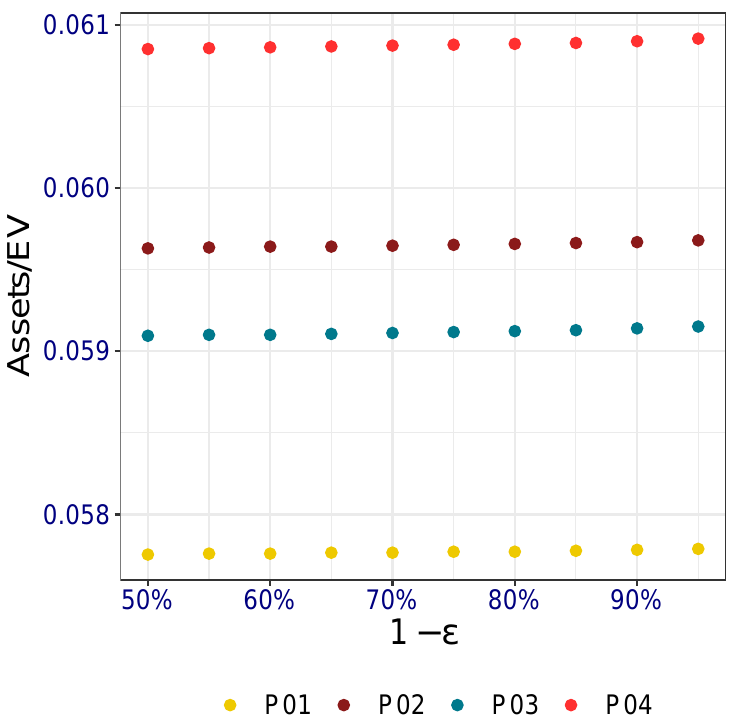
Figure 9. Impact of the portfolio structure on assets requirements at time t = 1.